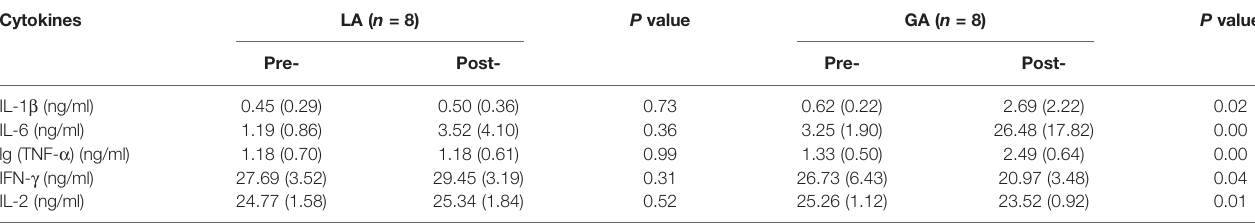
TABLE 2 | Levels of pro-in fl ammatory cytokines and lymphokines of the thermal ablation surgery patients [Mean (SD)]. Cytokines LA ( n = 8) P value GA ( n = 8) P value Pre- Post- Pre- Post- IL-1 b